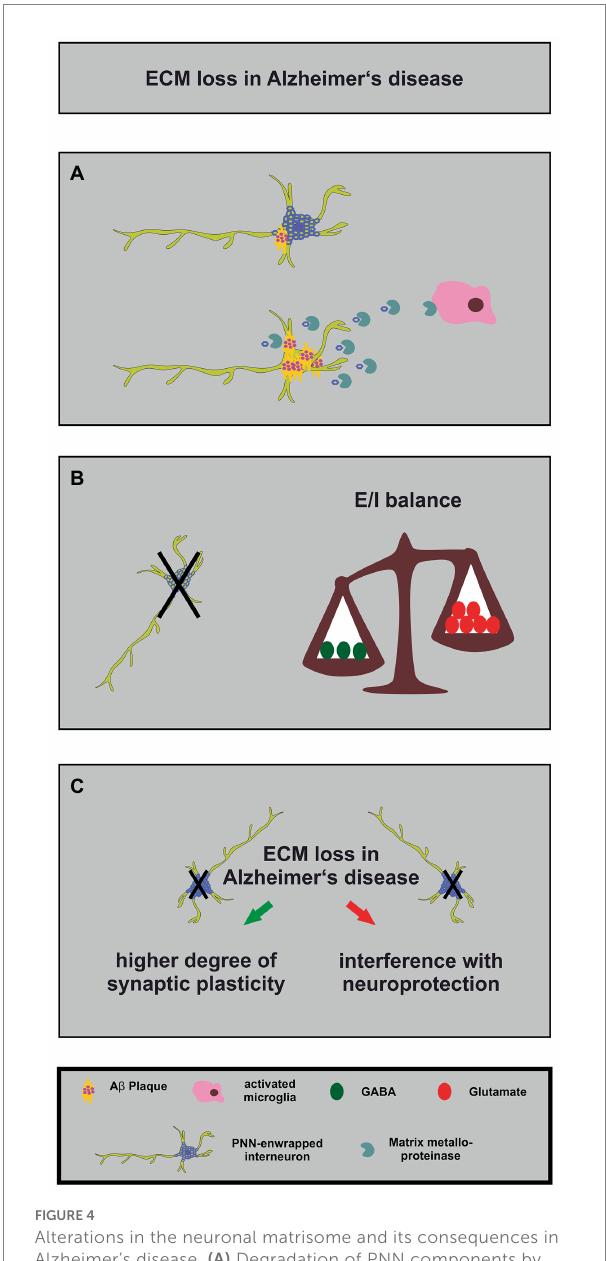
FIGURE 4 Alterations in the neuronal matrisome and its consequences in Alzheimer’s disease. (A) Degradation of PNN components by MMPs released by activated microglia (in pink) contributes to loss of neuroprotection of PNN-enwrapped interneurons (shown with mild A β -plaques), leading to increased A β -plaque accumulation and ultimately cell death in Alzheimer’s disease. (B) The loss of PNN-enwrapped interneurons (represented by a black cross) leads to a shift in the E/I balance towards increased excitation, as shown by the unbalanced scales. The left side of the scale, with fewer green circles representing GABA, is lower than the right side with more red circles representing glutamate, indicating a relative increase in excitatory signaling. This imbalance results from the loss of PNN-mediated neuroprotection, which highlights the critical role of the ECM in regulating neural circuit function in Alzheimer’s disease. (C) The ECM and interneuron loss in Alzheimer’s disease can lead, on the one hand, to increased synaptic plasticity (green arrow) as a compensatory mechanism for the loss of neuronal connections. On the other hand, it can interfere with PNN-mediated neuroprotection (red arrow). The loss of interneurons, in turn, can contribute to cognitive